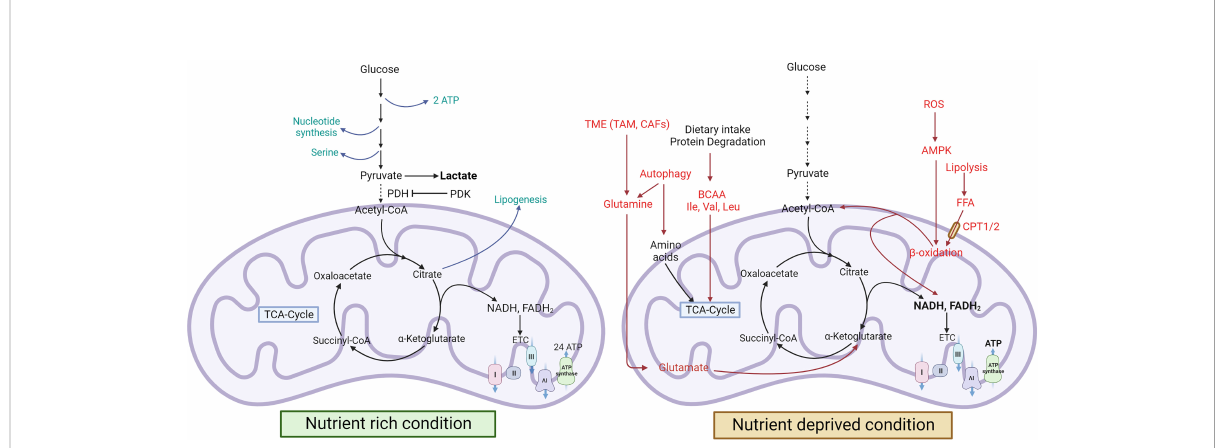
FIGURE 1 Cancer metabolism during nutrient-rich and stressed conditions. In nutrient-rich conditions, cancer cells use glucose to produce lactate, serine, and nucleotides, but in nutrient-deprived conditions, they induce FAO and autophagy for energy production (8, 9). Green colour indicates a nutrient-rich condition, and the red colour indicates a nutrient-deprived condition [FA, ,Fatty acid; Ile, Isoleucine; Val, Valine; Leu, Leucine; mTOR, Mammalian target of